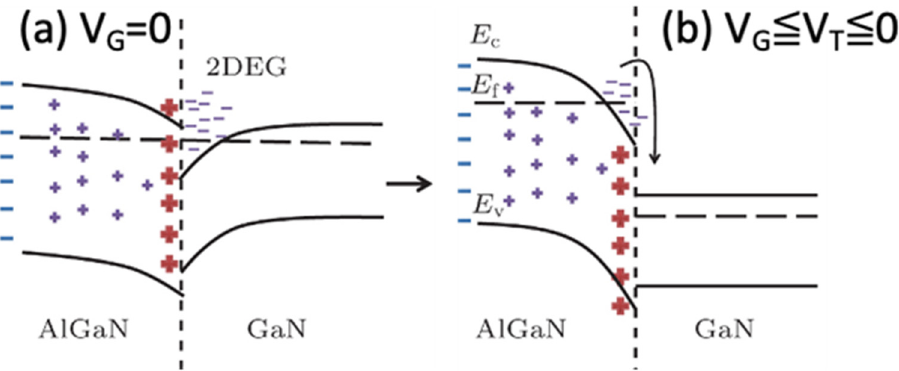
Figure 3. ( a ) The charge accumulation at the potential well as V G = 0, and ( b ) the accumulated charges depleted as V G < V T < 0 [19]. Figure reproduced with permission from Chin. Phys. B.